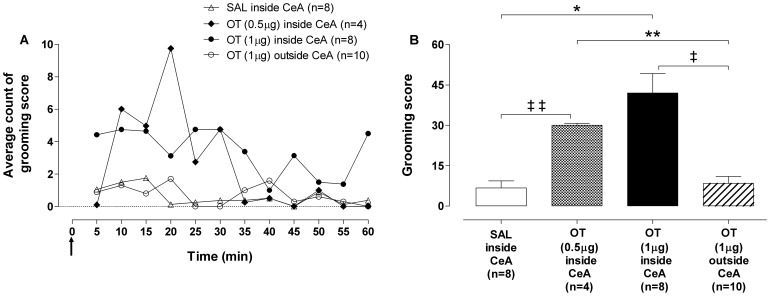
Grooming score following oxytocin microinjection into the central nucleus of amygdala.(A) Grooming score average count showing 5-min behavior sampling curve of oxytocin (OT) 0.5 µg, OT 1 µg or saline (SAL) into the central nucleus of amygdala (CeA) group and OT 1 µg outside CeA group. (B) grooming score (sum of grooming behavior over 60 min) of OT 0.5 µg (checkered bar), OT 1 µg (black bar, n = 8) or SAL (open bar) inside CeA group and OT 1 µg outside CeA group (striped bar). The arrow indicates the moment of microinjections. Data shown represent the means. (‡ ‡) SAL inside CeA group vs OT 0.5 µg inside CeA group; (*) SAL inside CeA group vs OT 1 µg inside CeA group; (**) OT 0.5 µg inside CeA group vs OT 1 µg outside CeA group; (‡) OT 1 µg inside CeA group vs OT 1 µg outside CeA group. p<0.05, Poisson model.